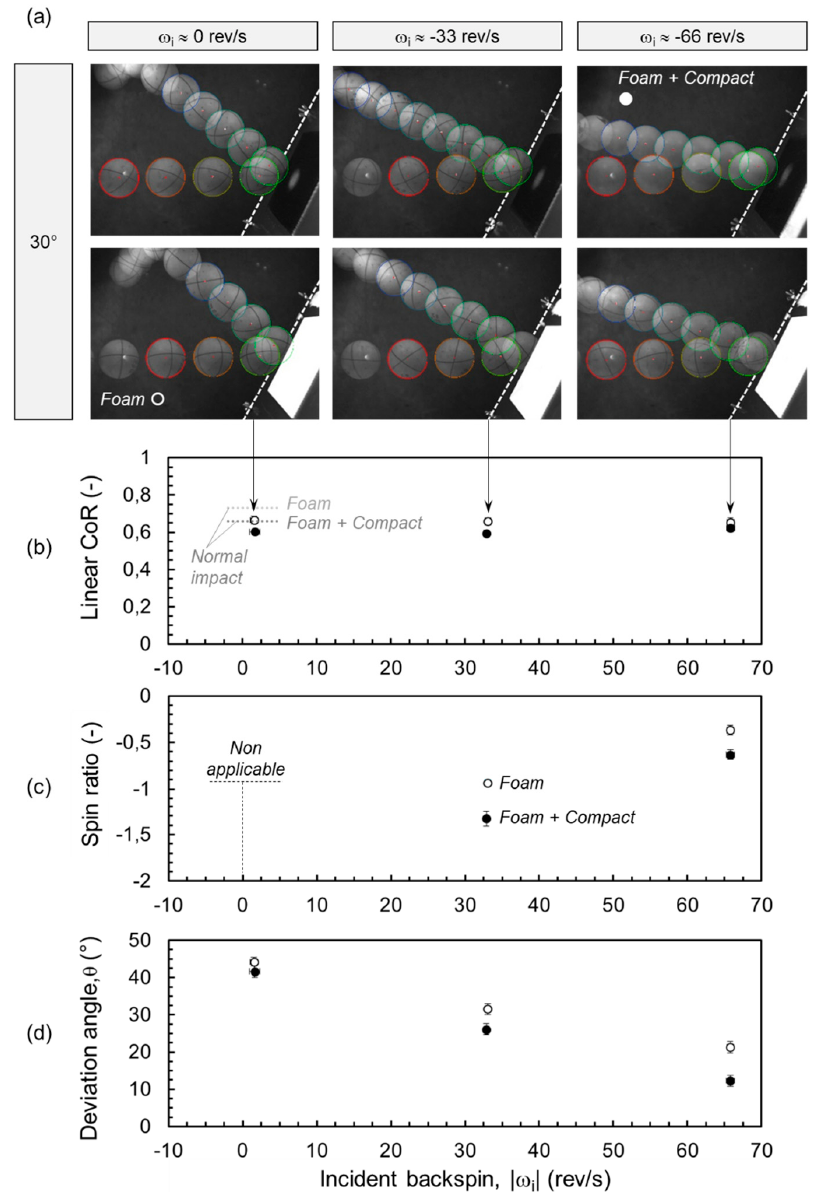
Figure 6. ( a ) Raw images of impact tests performed on the foam + compact and foam samples with → varying angular velocity ( (cid:107) V i (cid:107) = 14 m/s, T amb ). ( b ) Linear coefficient of Restitution as a function of the incident backspin. ( c ) Spin ratio as a function of the incident backspin. ( d ) Deviation angle as a function of the incident